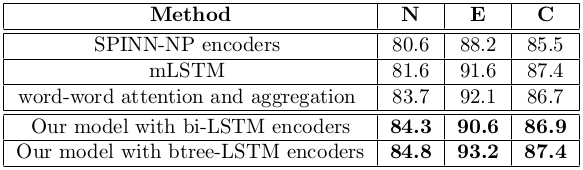
Table from the paper: A Neural Architecture Mimicking Humans End-to-End for Natural Language Inference
Table text:
Method
N
E
C
SPINN-NPencoders
80.6
88.2
85.5
mLSTM
81.6
91.6
87.4
word-wordattentionandaggregation
83.7
92.1
86.7
Ourmodelwithbi-LSTMencoders
84.3
90.6
86.9
Ourmodelwithbtree-LSTMencoders
84.8
93.2
87.4